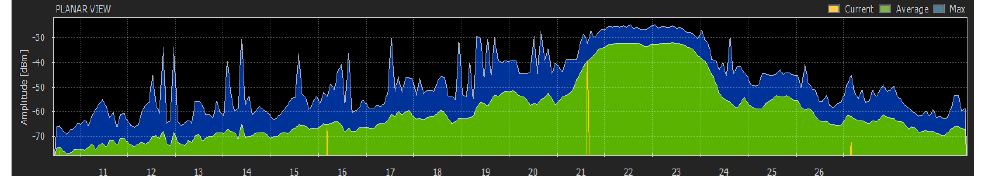
Figure 15. Spectrum of the 802.11g interference.